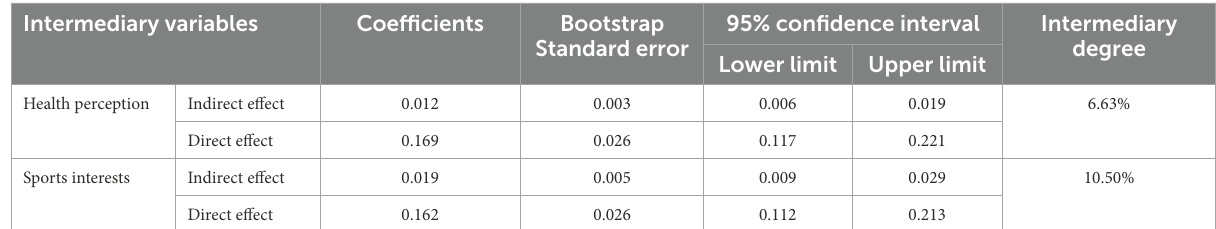
TABLE 5 Test results of mediation effect based on Bootstrap method.